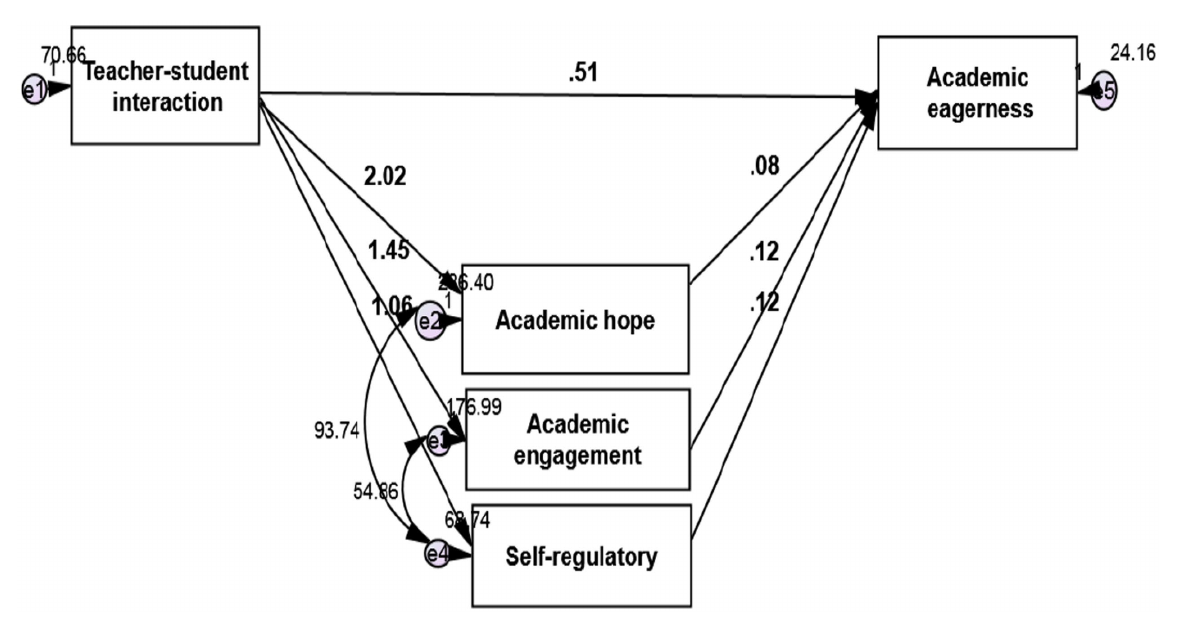
FIGURE 3 Model fit in non-standard estimation